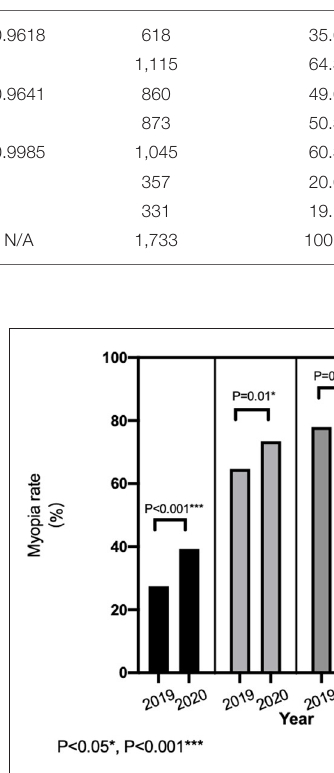
FIGURE 1 | Comparison of myopia rate among teenagers in different age groups before and after the epidemic.